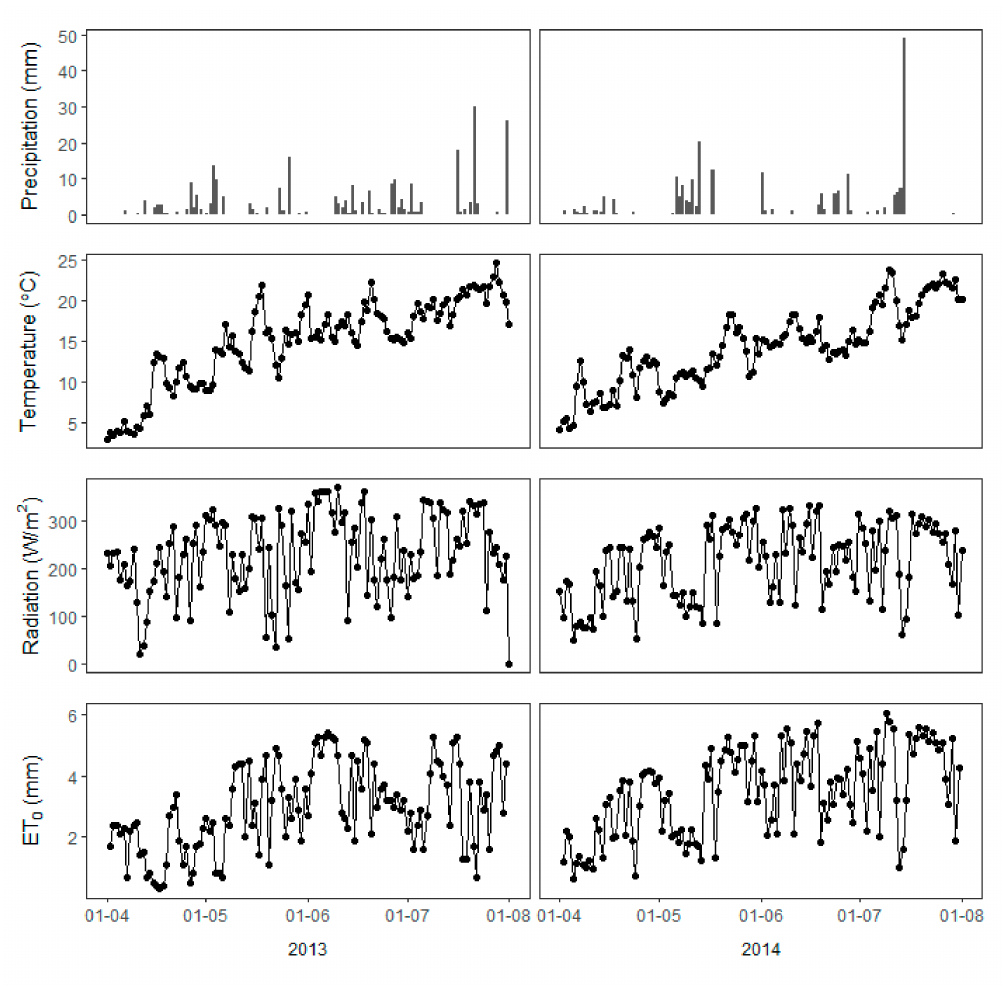
Figure 1. The daily precipitation (mm), mean temperature (Celsius), incoming radiation (W / m 2 ) and potential evapotranspiration (ET0) during the growing season 2013 and 2014, measured at the local weather